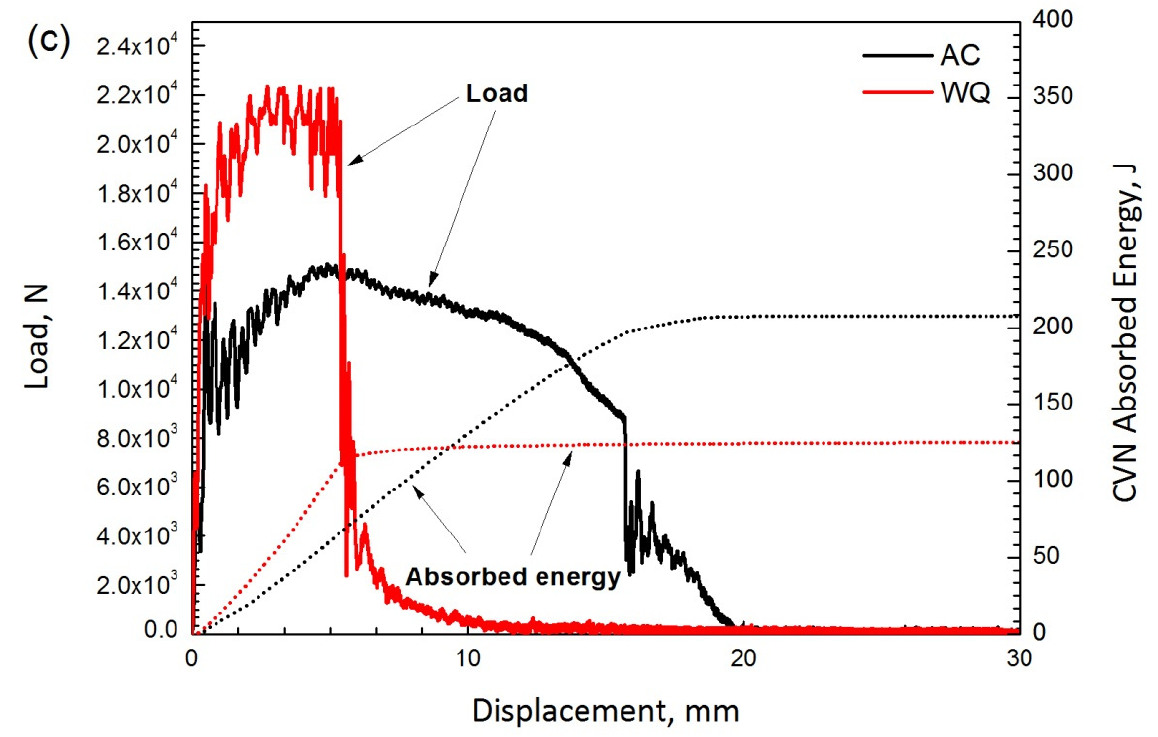
Figure 5. Typical load and absorbed energy versus displacement plots of base metal and CGHAZ by instrumented impact test at − 20 ◦ C. ( a ) base metal, ( b ) CGHAZ with 100 kJ/cm, ( c ) CGHAZ with 400 kJ/cm. AC indicates the air-cooled initial microstructure; WQ indicates the water-quenched initial microstructure.